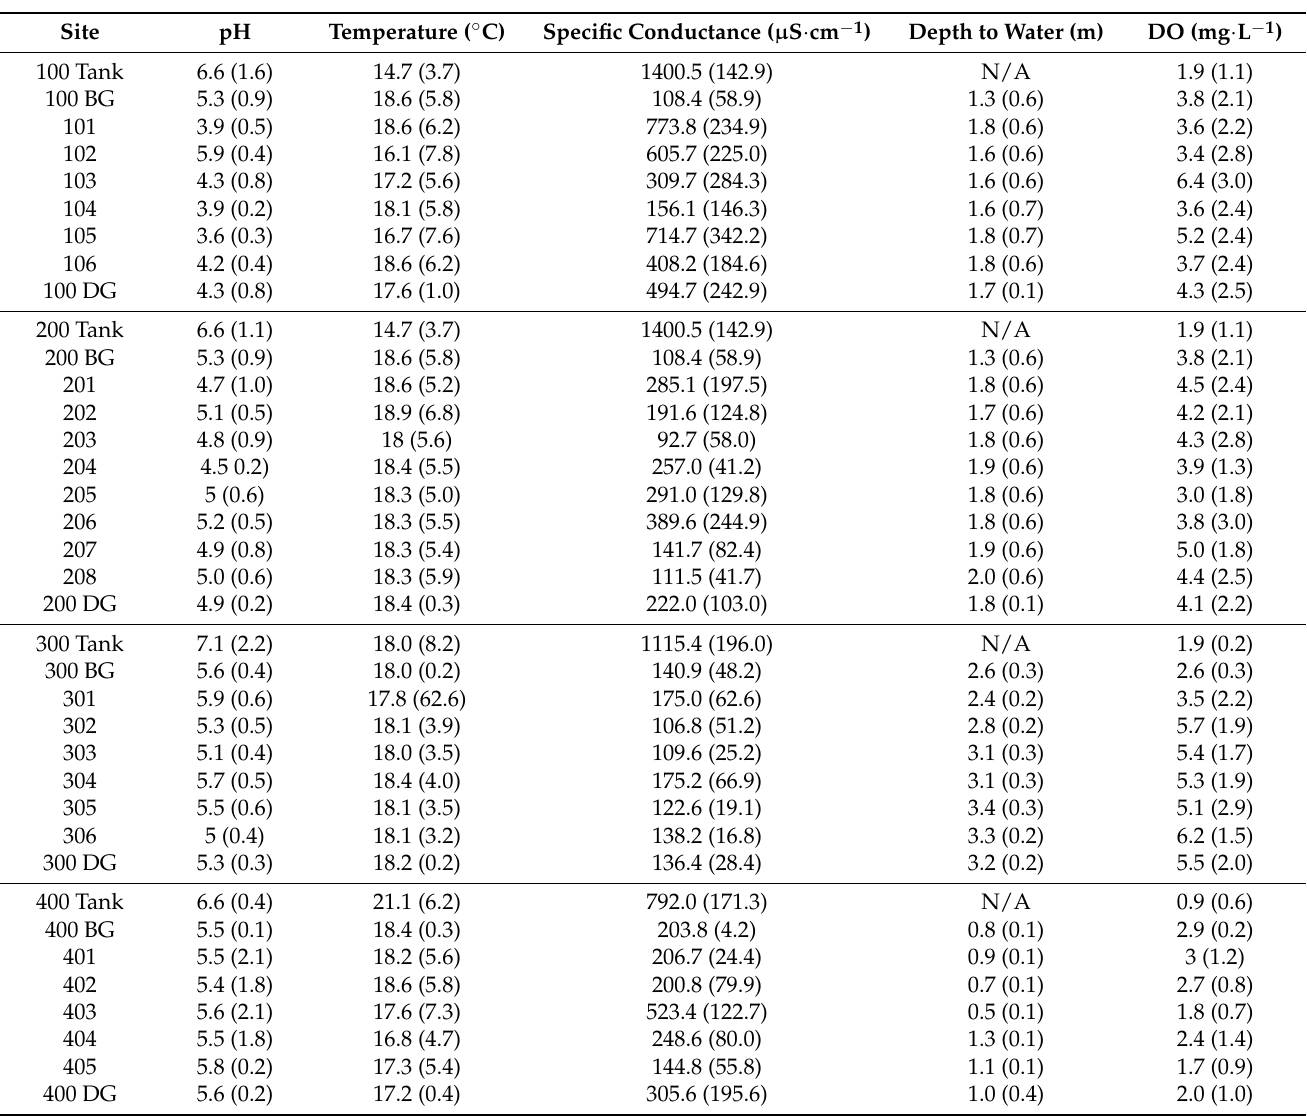
Table 2. Mean and (standard deviation) of physicochemical properties of water collected from the septic tank, background groundwater wells (BG, 301, 302, 401, 402), wells near (<3 m) the drainfield trenches (101–106, 201–208, 303–306, 403), and all wells down-gradient (DG) from the systems (all except